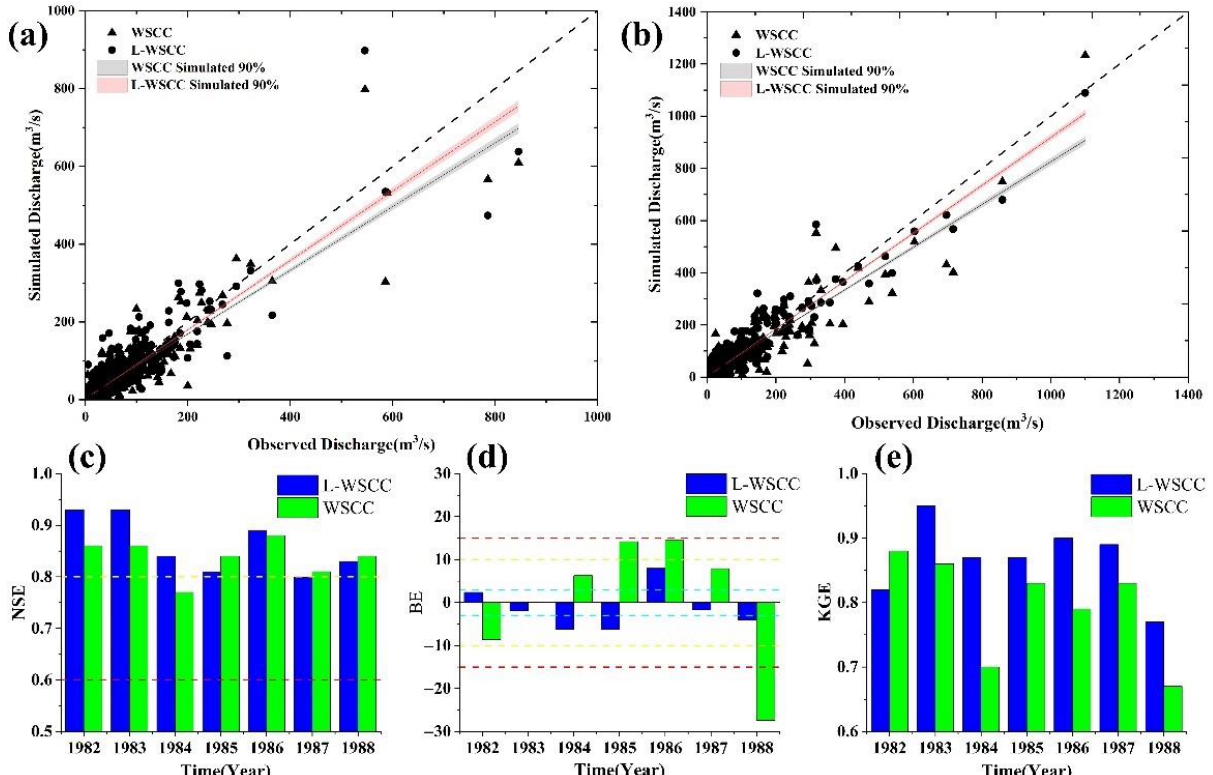
Figure 3. The simulation results on daily scale. Scatterplots of the simulated discharge against the observed discharge under calibration ( a ) and validation ( b ) period (the dashed line represents a straight line with a slope of 1, and the linear regression line is the solid line, shaded is 90% confidence band). The results of model assessment are ( c ) Nash–Sutcliffe efficiency (NSE). The red dotted line represents the dividing lines where the results are “satisfactory” to “good”, the yellow are “good” to “very good”. ( d ) Percent bias error (BE). The red dotted line represents the dividing lines where the results are “unsatisfactory” to “satisfactory”, the yellow are “satisfactory” to “good” and the cyan are “good” to “very good”. ( e ) Kling–Gupta Efficiency